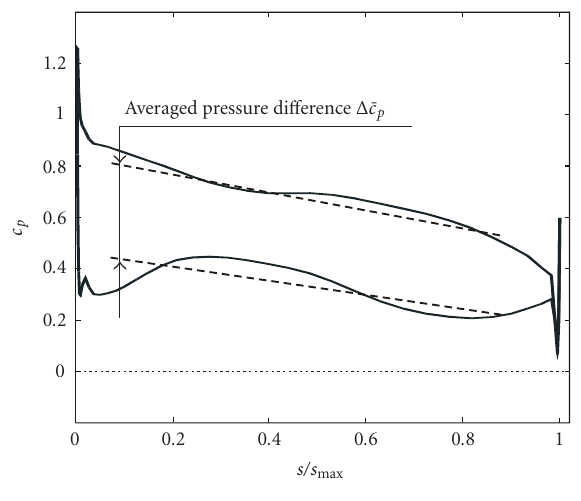
Figure 4: Comparison of the FSQP and the Hooke-Jeeves optimiza- tion algorithm applied to the 2D Rosenbrock function.